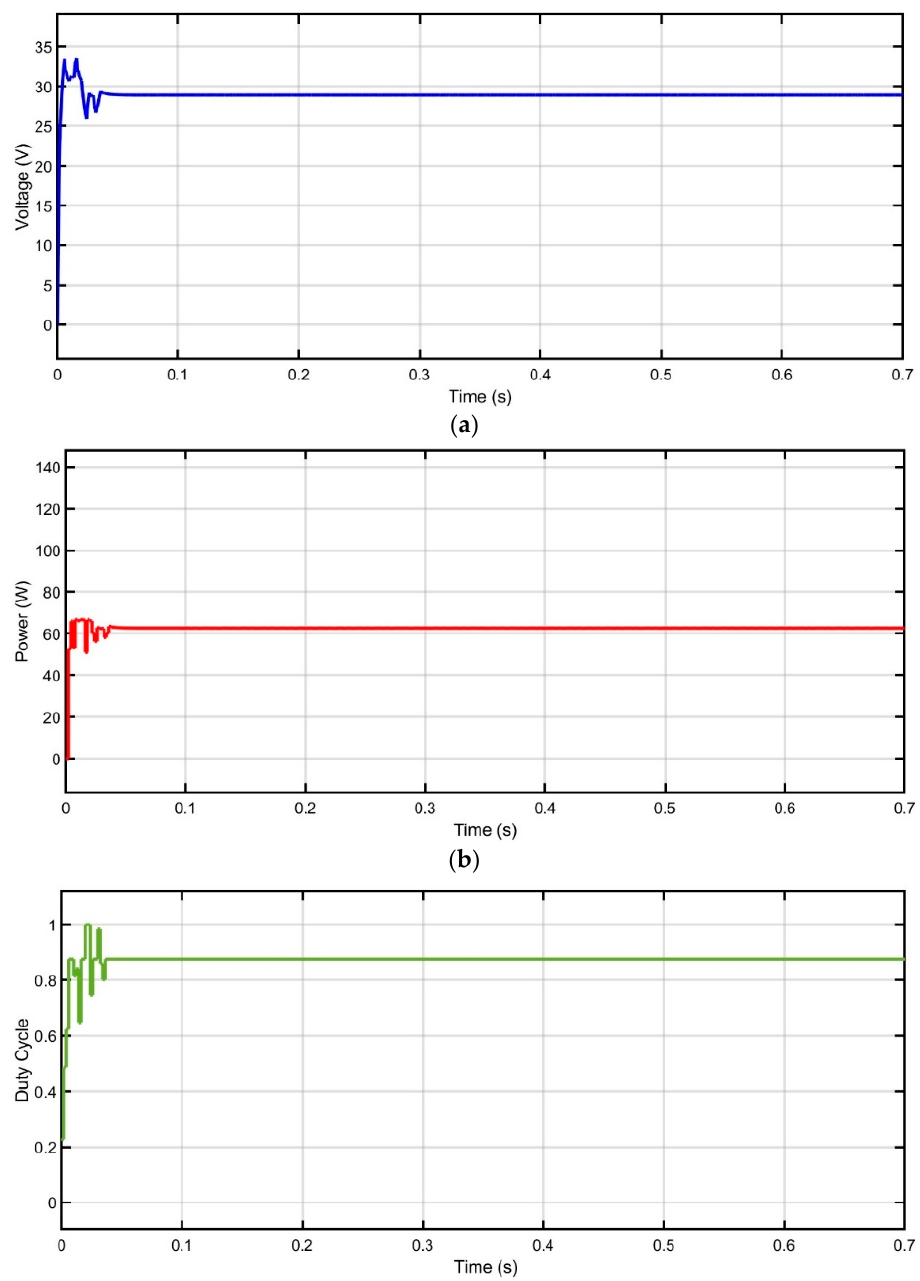
Figure 17. ( a ) The voltage, ( b ) the power, and ( c ) the duty cycle using the IABC method.